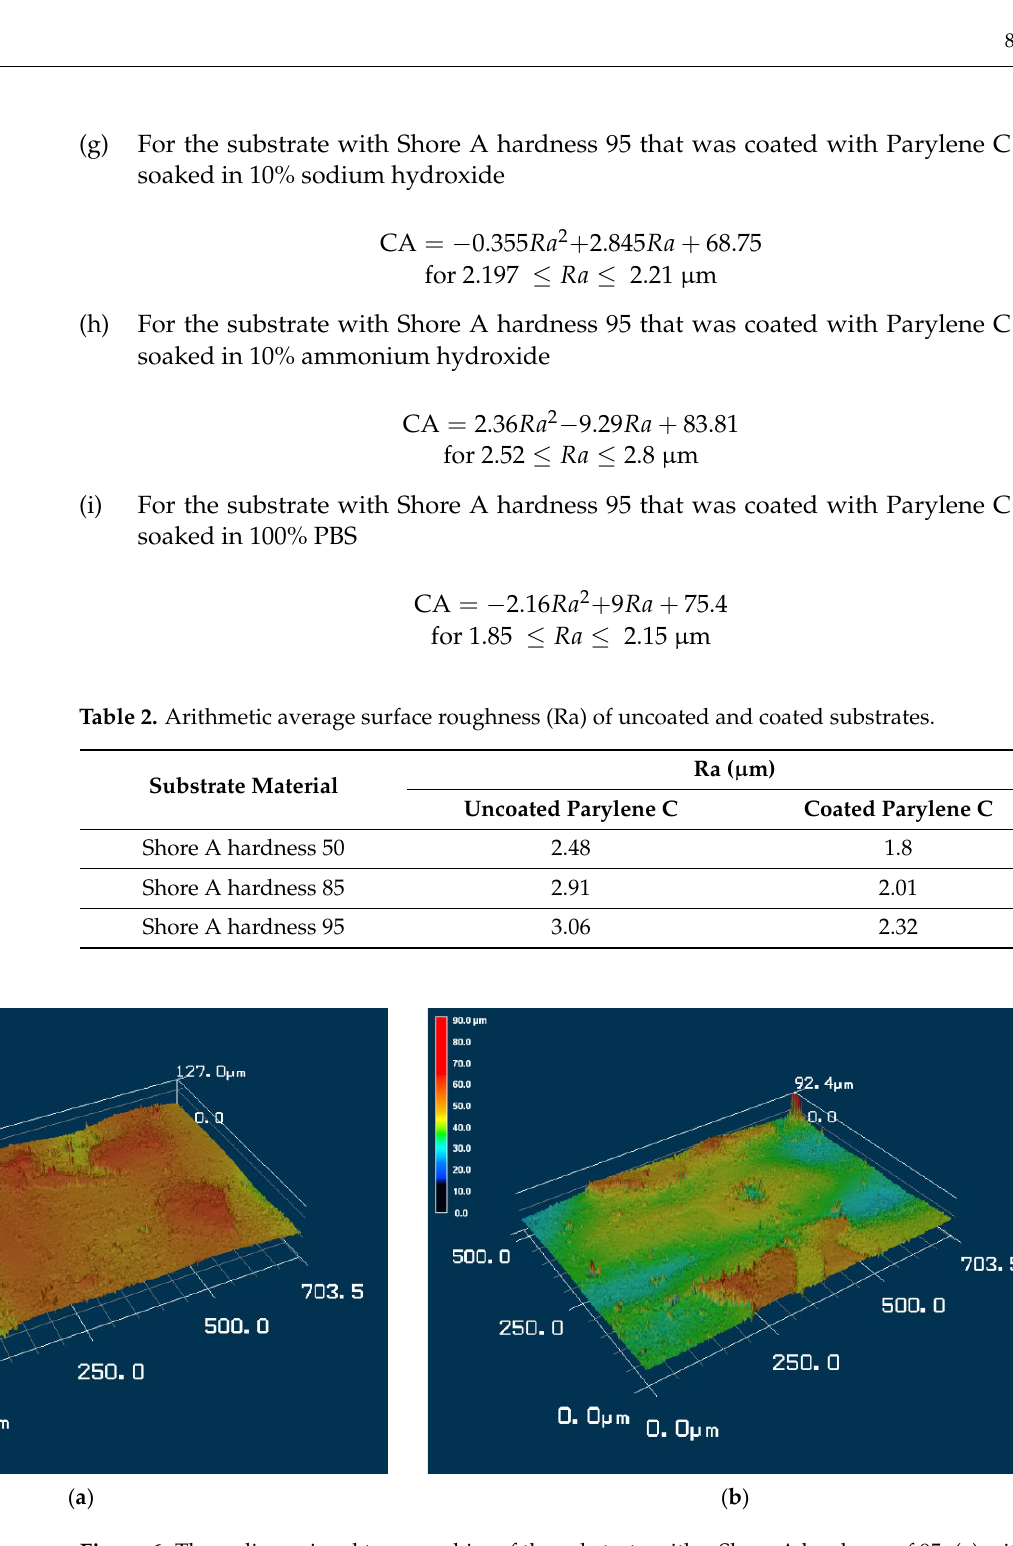
( b ) Figure 7. Surface SEM morphologies of the substrate with a Shore A hardness of 95: ( a ) without and ( b ) with Parylene C coating.